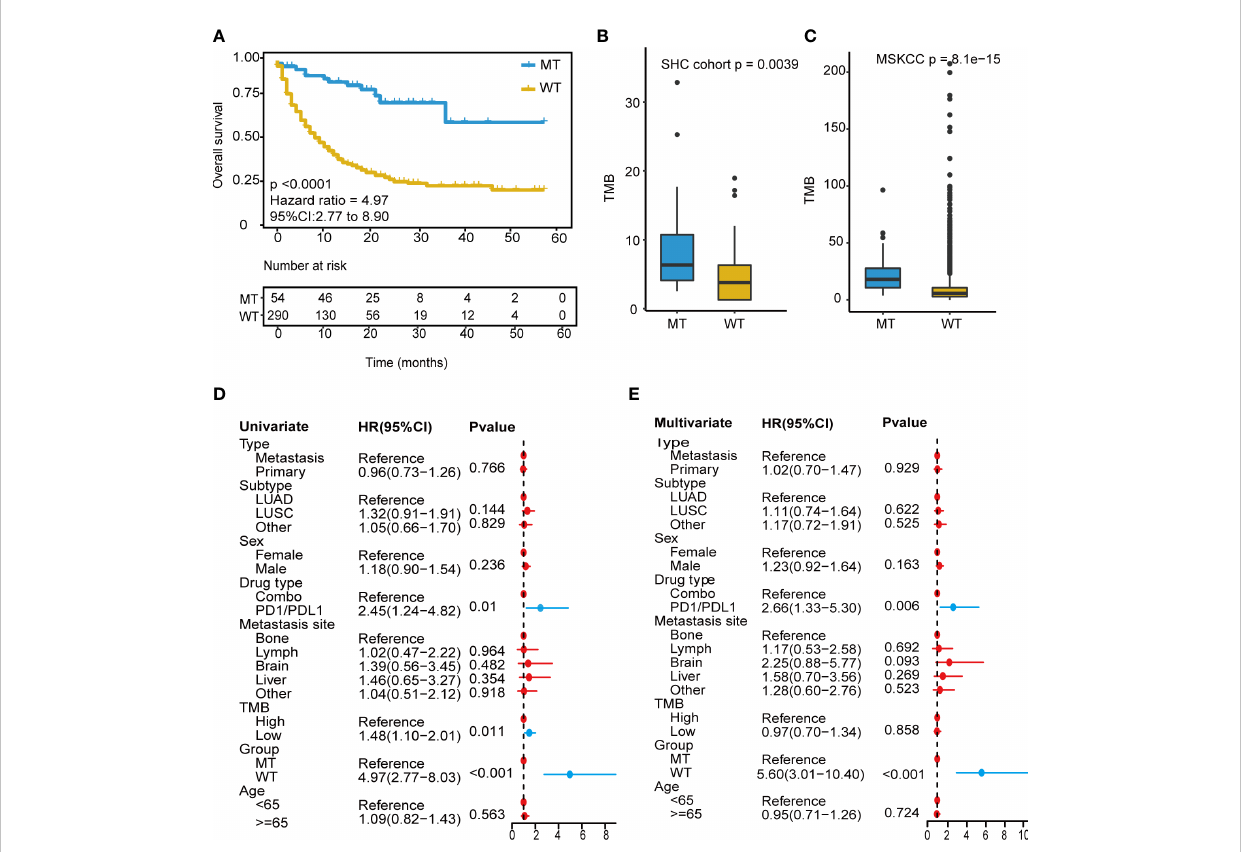
FIGURE 3 Development of the mutation-based model. (A) Kaplan-Meier survival analysis for OS between MT group and WT group in the training cohort. (B, C) TMB analysis between MT group and WT group in SHC cohort and training cohort. (D) Univariate Cox regression analysis of clinical factors and the model for prognosis after ICIs treatment. (E) Multivariate Cox regression analysis of clinical characteristics and the model for prediction after ICIs treatment. OS, overall survival; MT group, patients with ≥ 2 mutant genes; WT group, patients with <2 mutant gene; TMB-H, tumor mutational burden-high ( ≥ 10 mutation/Mb); TMB-L, tumor mutational burden-low (<10 mutation/Mb); ICIs, immune checkpoint